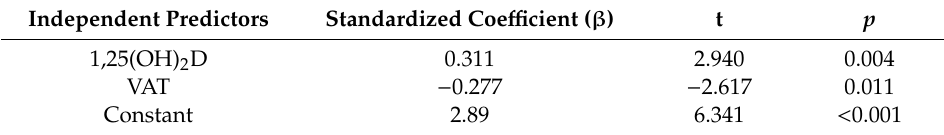
Table 5. Determinants of osteocalcin levels—stepwise multivariate